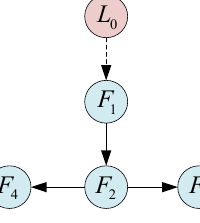
Figure 2. Communication topology of multi-agent systems.